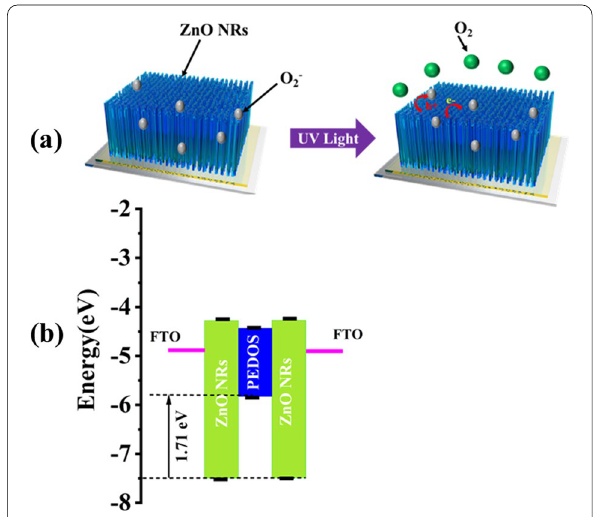
Fig. 7 a The oxygen adsorption/desorption process of ZnO NRs. b The scheme of energy band of ZnO NRs/PEDOS p-n UV